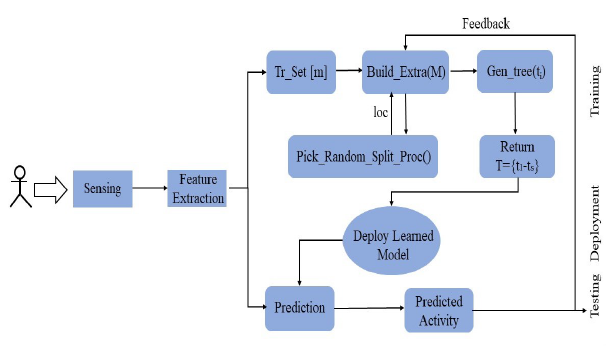
Figure 1. Overall Block Diagram of Proposed